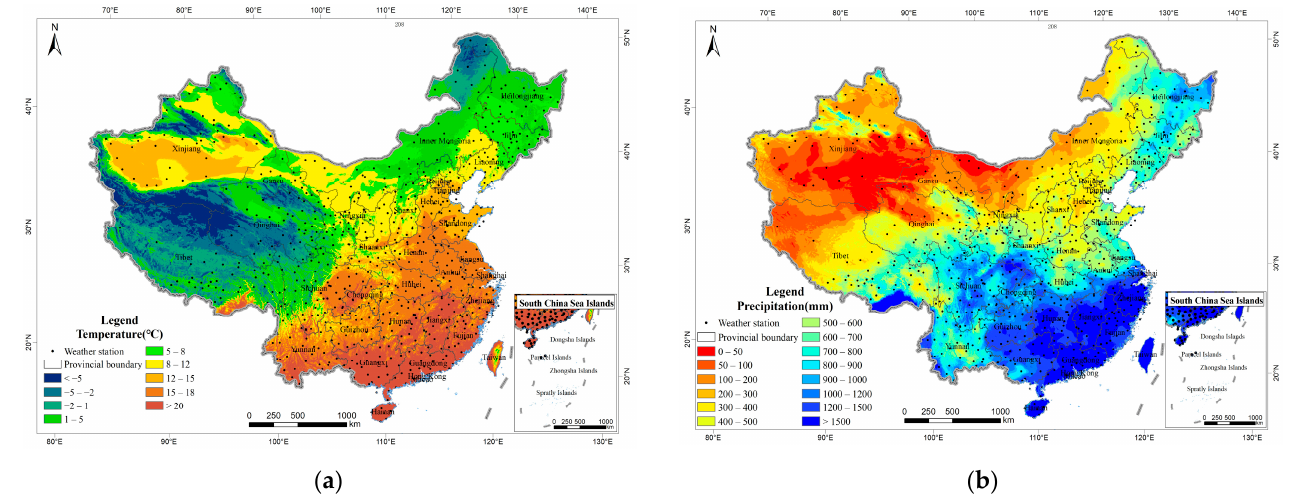
Figure 2. The spatial distribution of China’s total annual precipitation ( a ) and annual average temperature ( b ) in 2019.